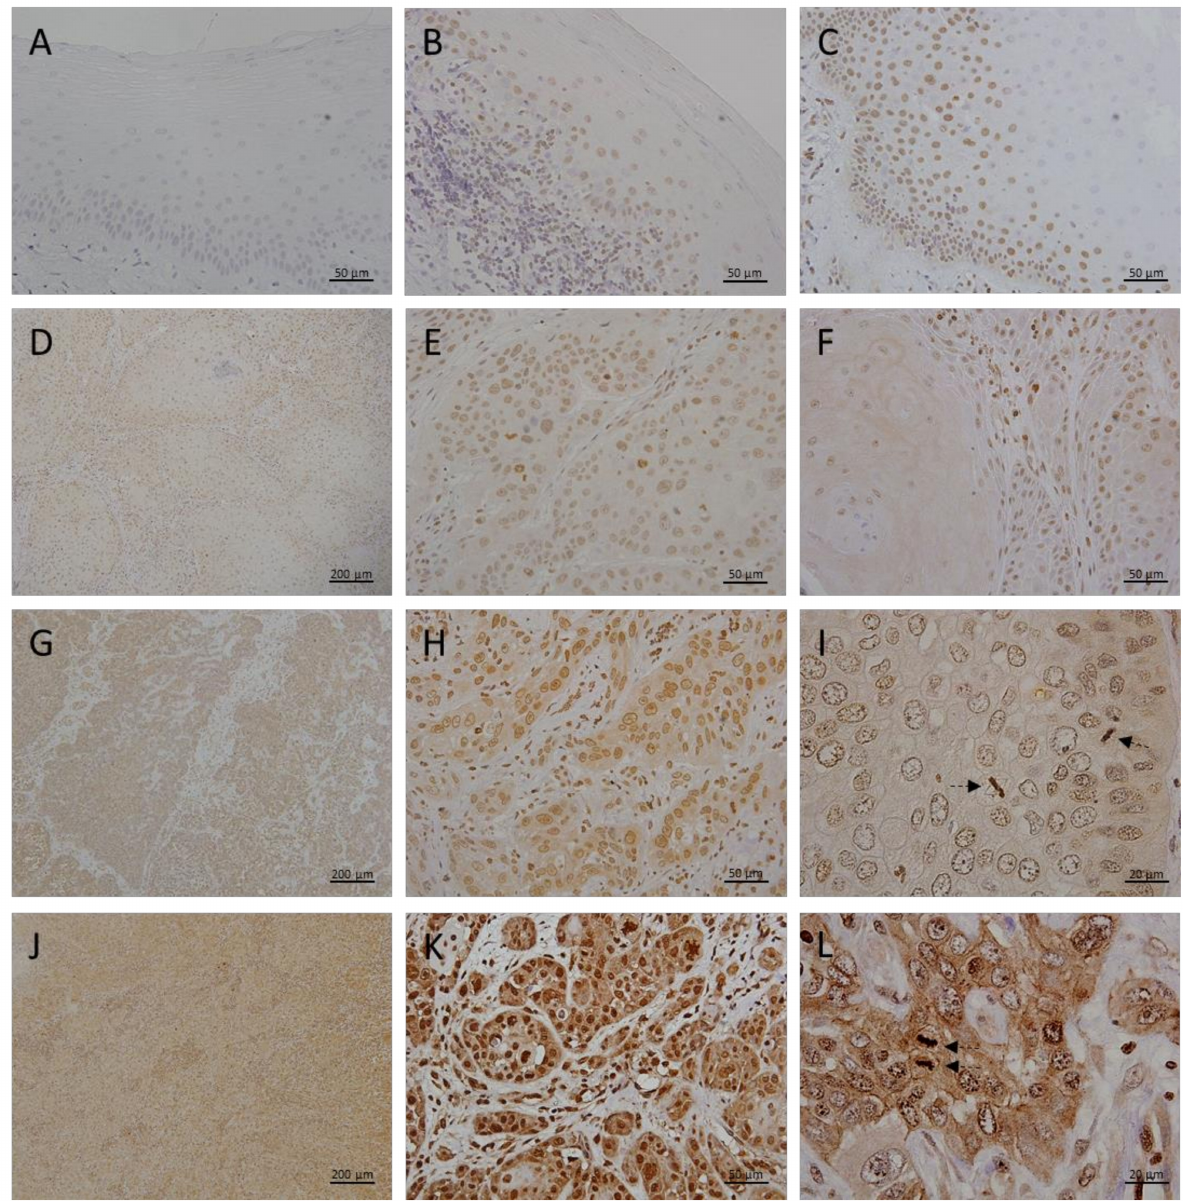
Figure 3. Megalin expression in premalignant and malignant oral squamous epithelial lesions. Representative photomi- crographs show immunohistochemical staining with the anti-megalin antibody on paraffin-embedded sections of tissue samples obtained from subjects with healthy oral mucosa ( A ), patients with oral lichen planus ( B ), oral leukoplakia ( C ), grade I OSCC ( D – F ), grade II OSCC ( G – I ), and grade III OSCC ( J – L ). Arrows on I and L indicate chromosomal megalin immunopositivity in mitotic cells. Magnifications: ( D , G , J ) × 100; ( A – C , E , F , H , K ) × 400; ( I , L ) ×